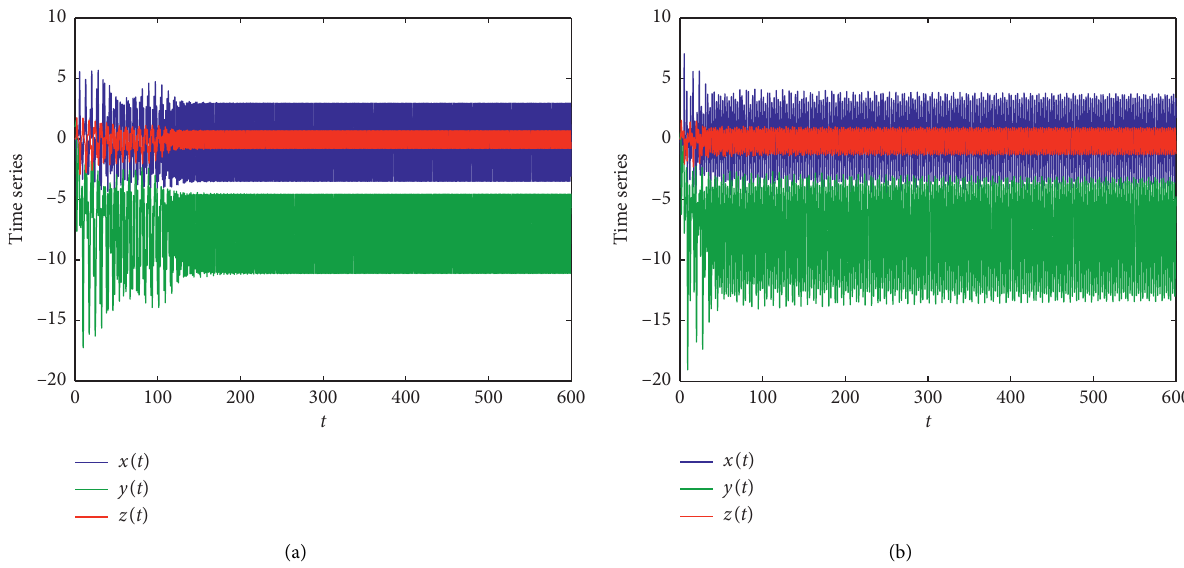
Figure 6: Time series of system (3a)–(3c) with τ ( 0 . 1 , 0 , 0 ) and means